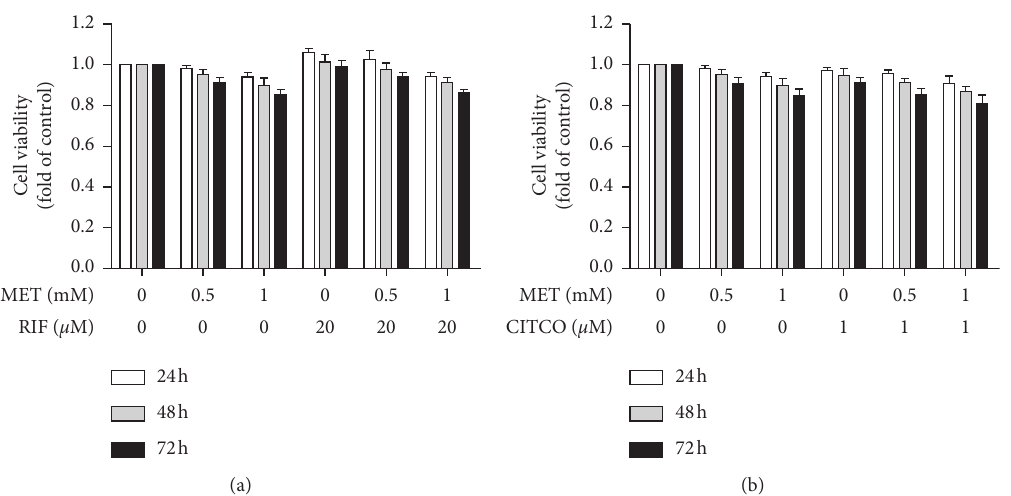
Figure 1: Cell viability of HepaRG cells following exposure to metformin alone and in combination with RIF or CITCO. (a) HepaRG cells were exposed to vehicle control (a similar volume of DMSO), metformin (MET; 0.5, 1mM), RIF (20 μ M), or metformin in combination with RIF for 24, 48, and 72 h. (b) HepaRG cells were exposed to vehicle control (a similar volume of DMSO), metformin (0.5, 1mM), CITCO (1 μ M), or metformin in combination with CITCO for 24, 48, and 72h. Cell viability was monitored by CCK8 assay. The data shown are the mean ± SEM ( n � 3). ( ∗ P < 0 . 05, ∗∗ P < 0 . 01 compared to the control